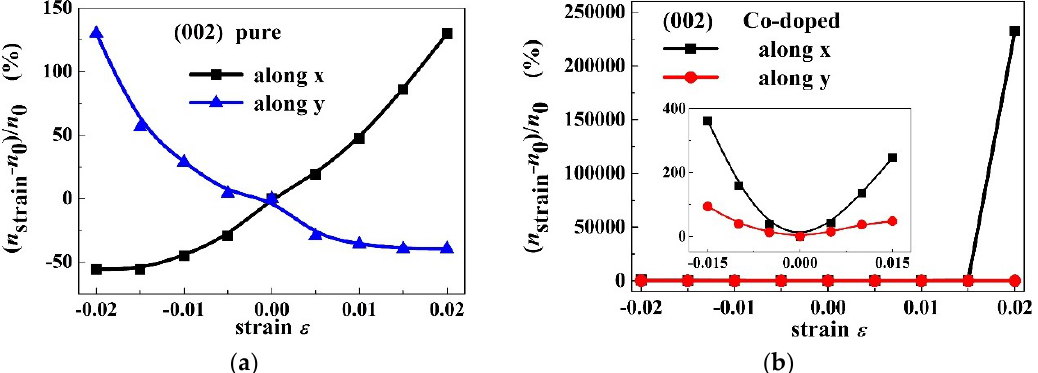
)/ n n n  ( as a function of strain for ( a ) 0 0   = −0.02 and